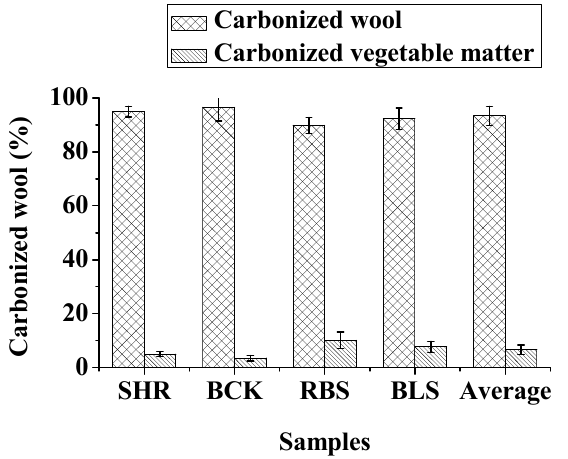
Figure 9. Percentages of carbonized wool and carbonized vegetable matter after carbonization.